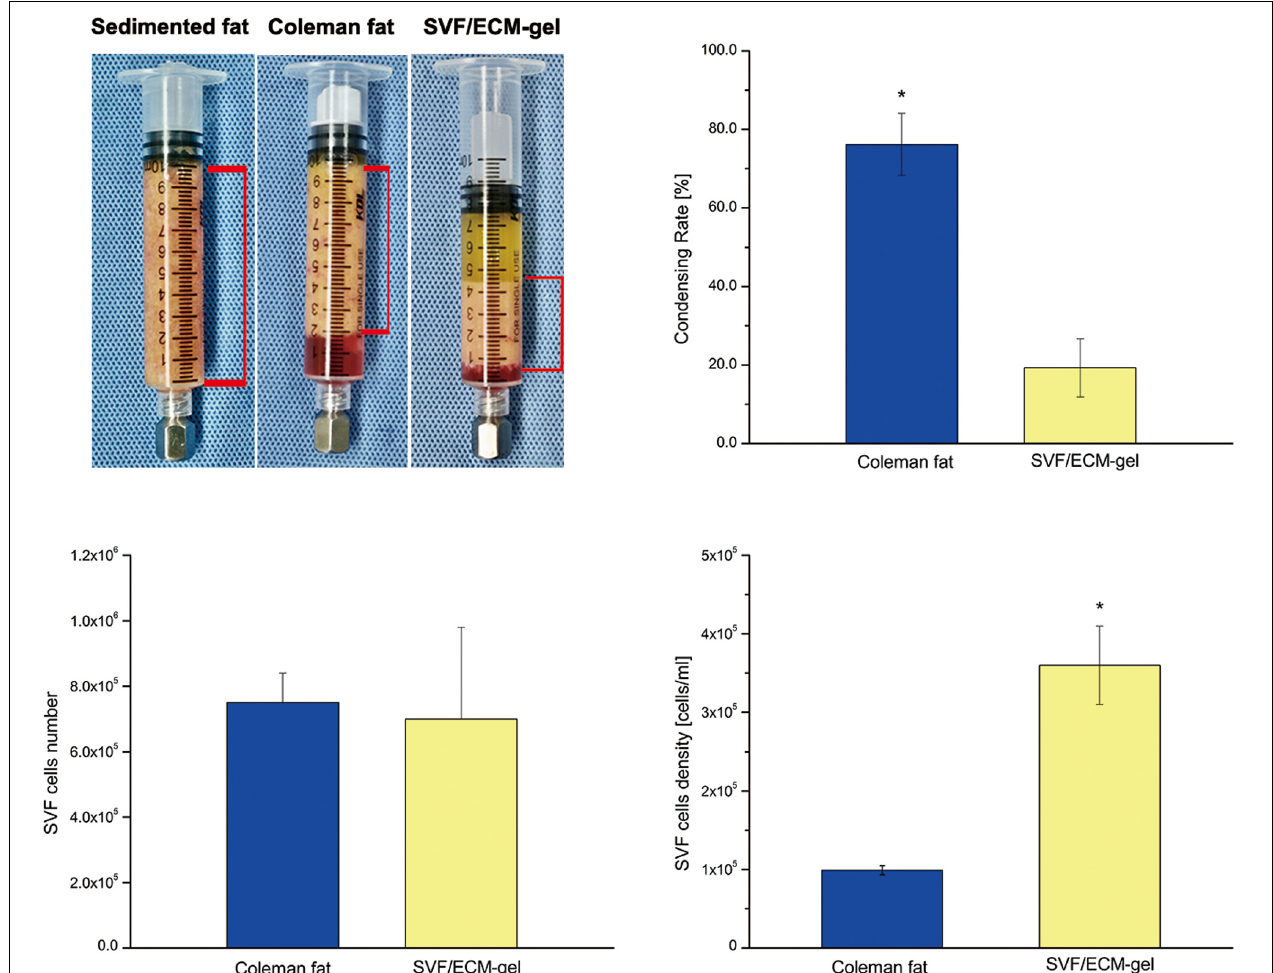
FIGURE 5 | Condensation rate of the fat samples and the total number and density of SVF mixed cells. General observation (upper left) and statistical analysis (upper right) of the volume changes in the two types of fat samples with the same initial volume during the preparation of Coleman fat and SVF/ECM gel. * P <